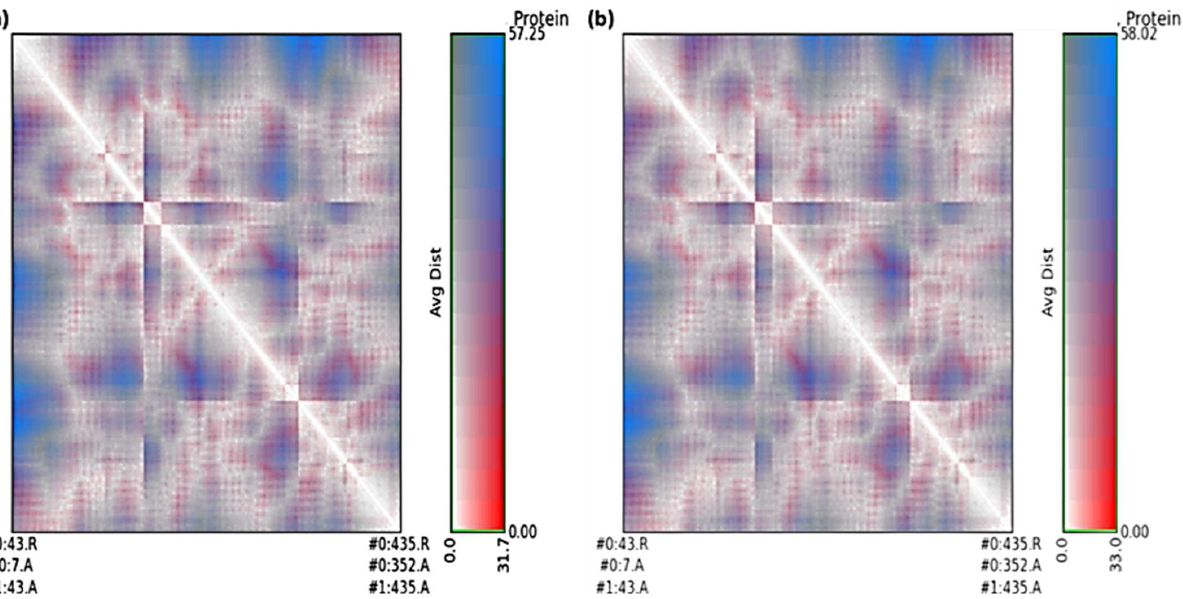
Figure 13. RR distance map between unbound dopamine receptor and after simulation for SRXD ( a ), and CtcD ( b ). On the map, the white oblique represents the zero distance between two amino acid residues, whereas the red and blue elements depict residue pairs with the biggest distance deviations between the two forms. The average radius of gyration (Rg) value of 28.75 and 28.52 Å was observed for SRXD and CTcD, respectively. Along the simulation time, Rg decreased, indicating that the structures became more compact (Figure 14).